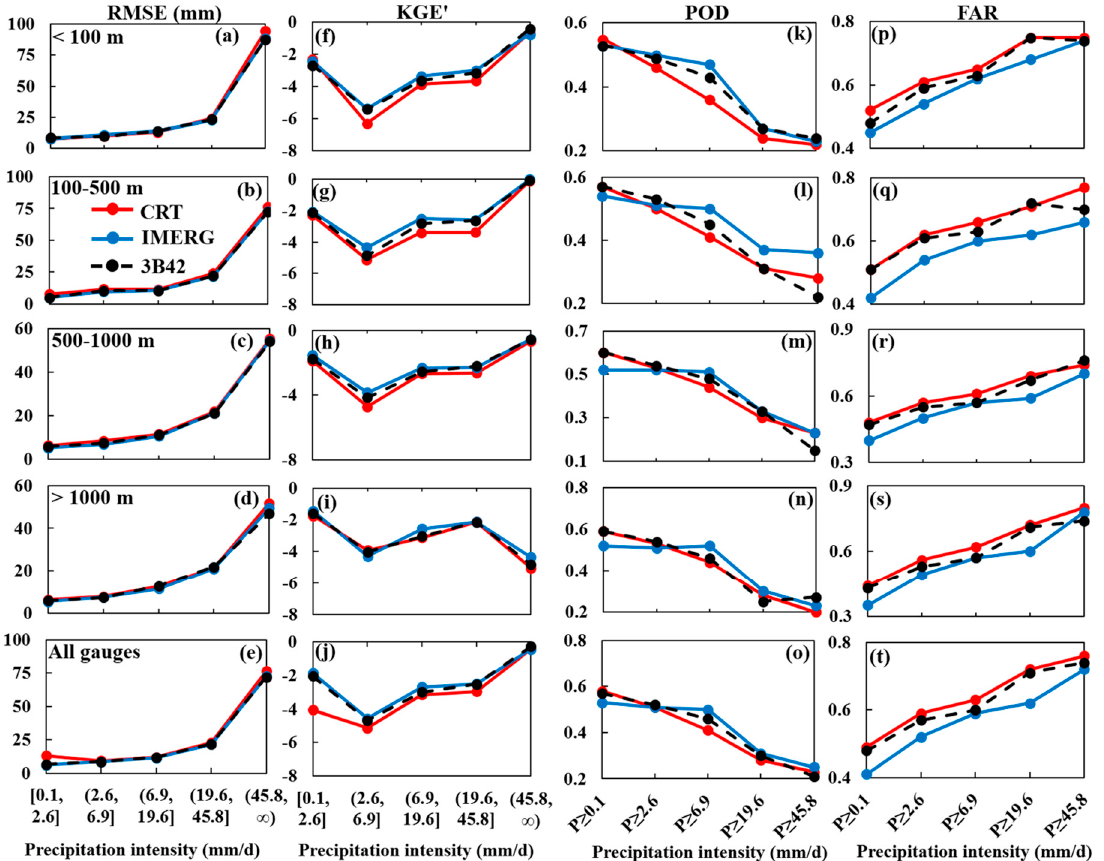
Figure 6. RMSE ( a – e ), KGE’ ( f – j ), POD ( k – o ), and FAR ( p – t ) from CRT, IMERG, and 3B42 products in different precipitation intensity over different elevation ranges.